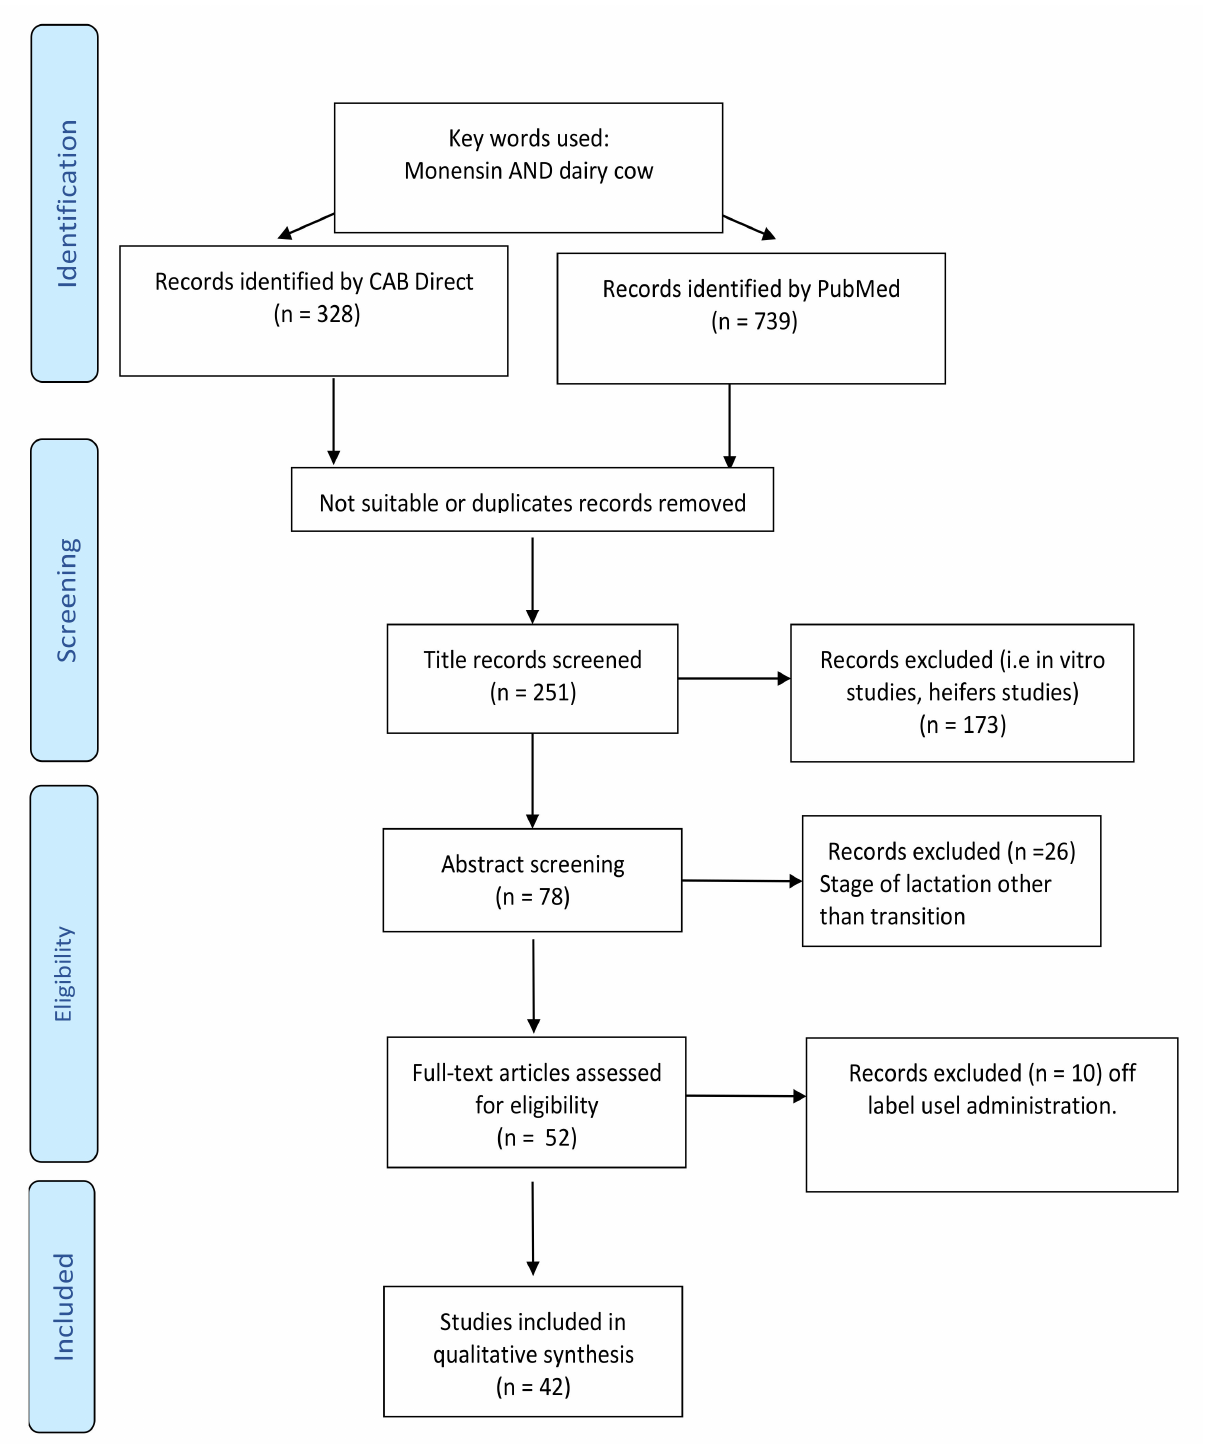
Figure 1. Search strategy and screening process used for the eligibility of the manuscripts according to PRISMA